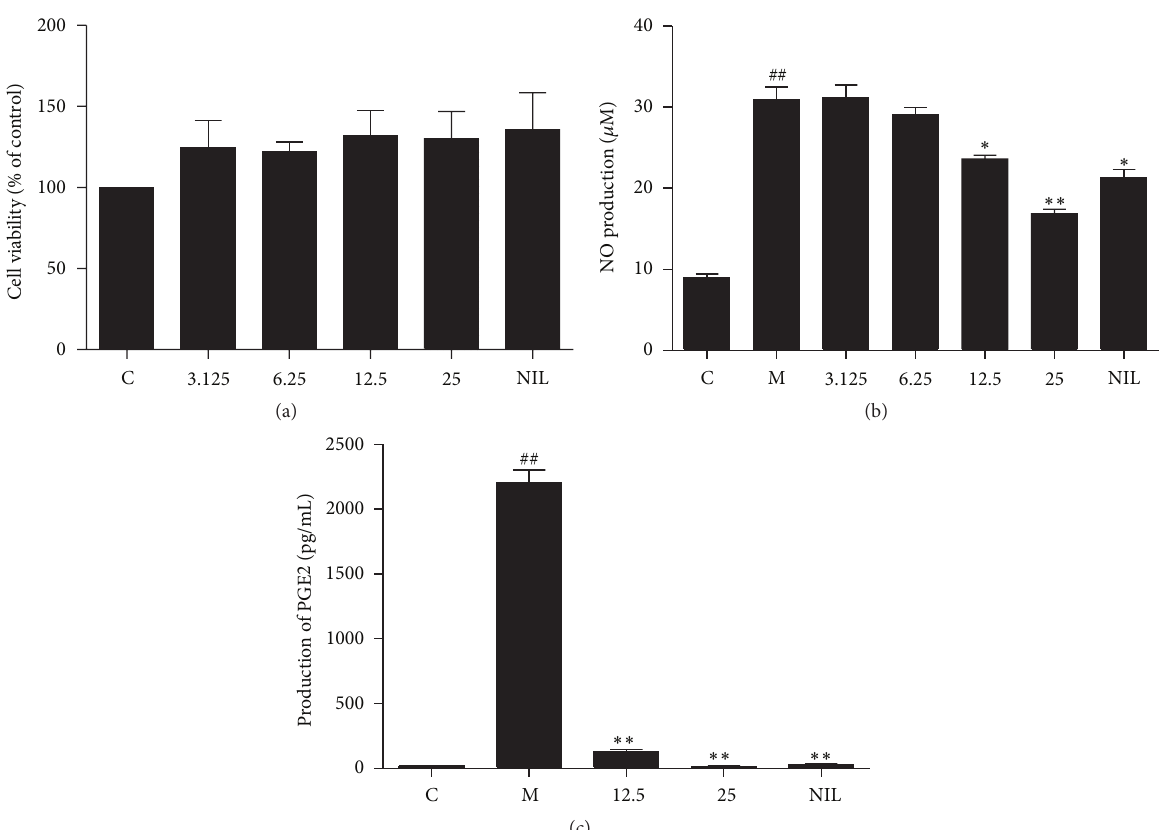
Figure 2: Effect of TIE on NO and PGE2 production in LPS/IFN 𝛾 -stimulated RAW264.7 macrophages. (a) RAW264.7 cells were treated with TIE (3.125–25 𝜇 M) or 50 𝜇 M L-NIL for 24 h. Cell viability was measured by MTT assay. Changes in survival are represented as percentages of the control group. (b) Cells were plated at a density of 1 × 10 5 cells/well in a 96-well plate and allowed to attach overnight. Cells were treated with the various concentrations of TIE (3.125–25 𝜇 M) or 50 𝜇 M L-NIL and incubated with LPS (100ng/mL) and IFN 𝛾 (10U/mL) in fresh FBS- free medium for 24 h. The nitrite production was measured by the Griess reaction. (c) Cells were treated with the indicated concentrations of TIE (12.5, 25 𝜇 M) and incubated with LPS (100ng/mL) and IFN 𝛾 (10U/mL) in fresh FBS-free medium for 24 h. The PGE2 concentration in cell supernatant was determined by ELISA kit. The values were presented as mean ± SEM of three independent experiments. ## 𝑃 < 0.01 ; # 𝑃 < 0.05 versus control group; ∗∗ 𝑃 < 0.01 ; ∗ 𝑃 < 0.05 versus model